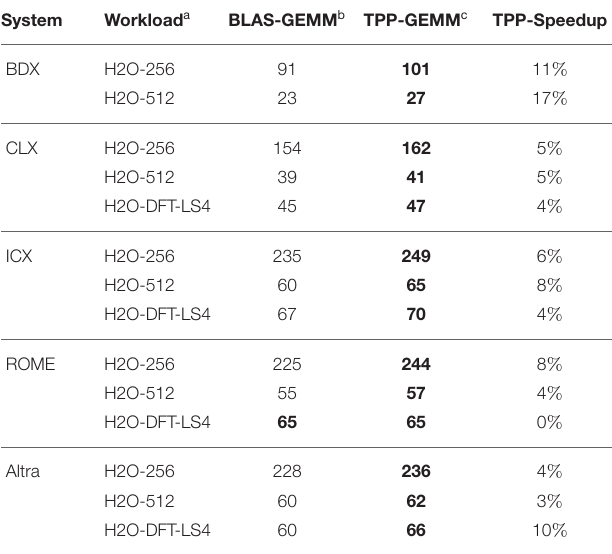
TABLE 4 | CP2K performance (Cases/Day) of three workloads fitting into single systems with two processors. System